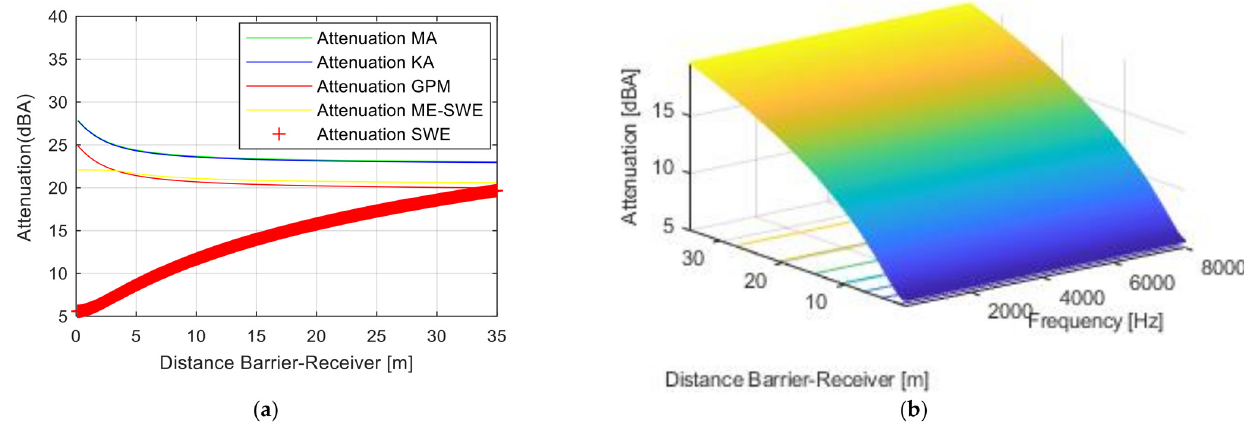
Figure 5. Sound attenuation as a function of the distance barrier-receiver and for a pure tone. ( a ) Frequency = 2000 Hz, ( b ) attenuation due to SWE. Range frequency 100–8000